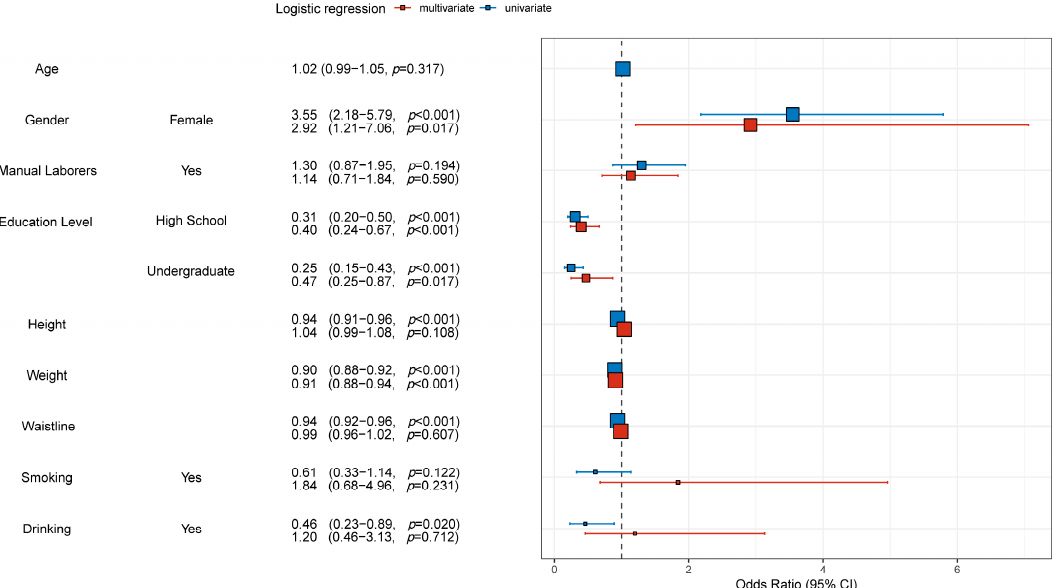
Figure 1. Univariate and multivariate logistic regression analyses for the training group. Univariate and multivariate logistic regression analyses were performed for all factors. Odds ratios, confidence intervals, and p -values were shown. p < 0.05 meant that the difference was statistically significant. Abbreviations: OR, Odds ratios; CI, confidence intervals.